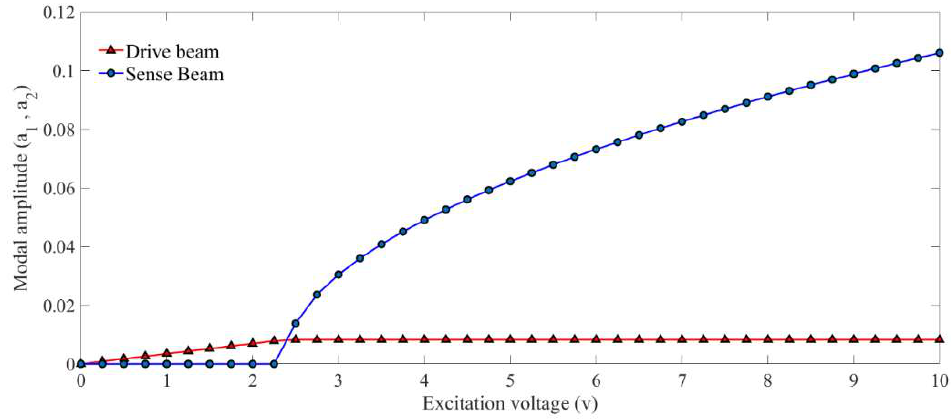
Figure 5. Simulated saturation curve by two-variable perturbation solution.